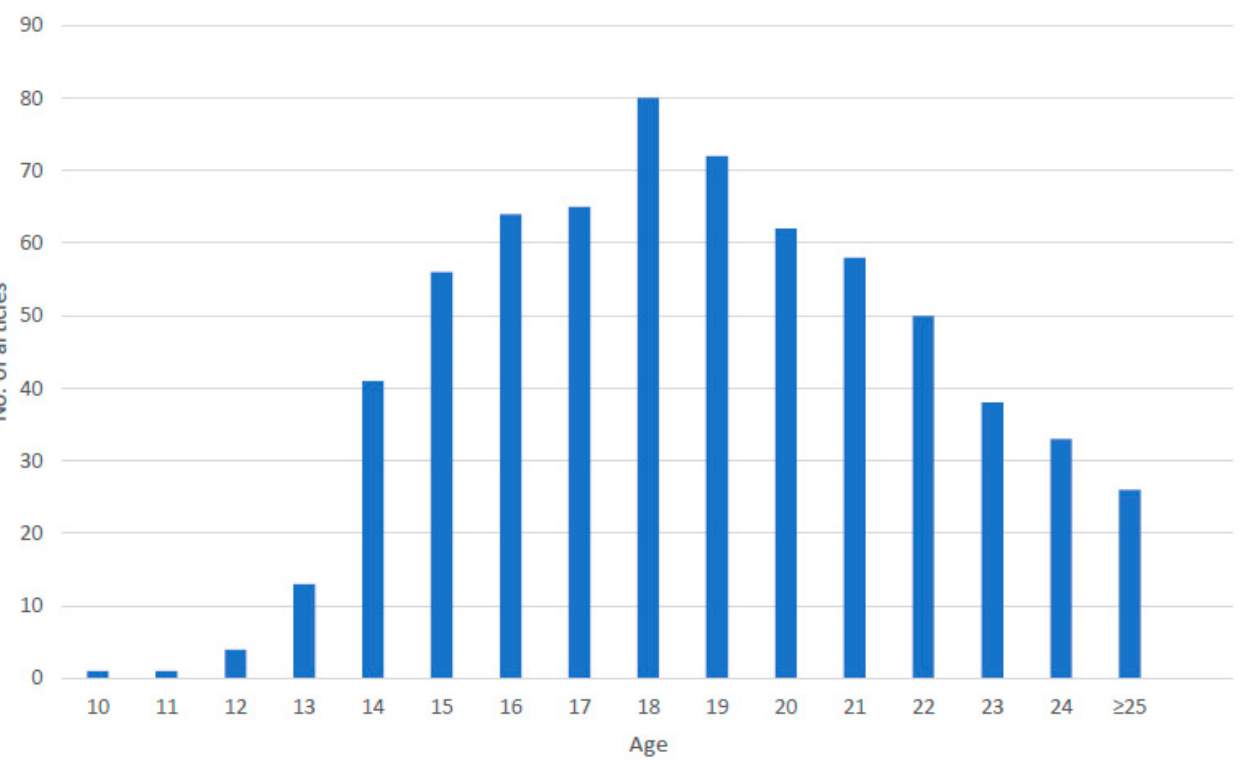
Figure 5. Participant ages across included records.